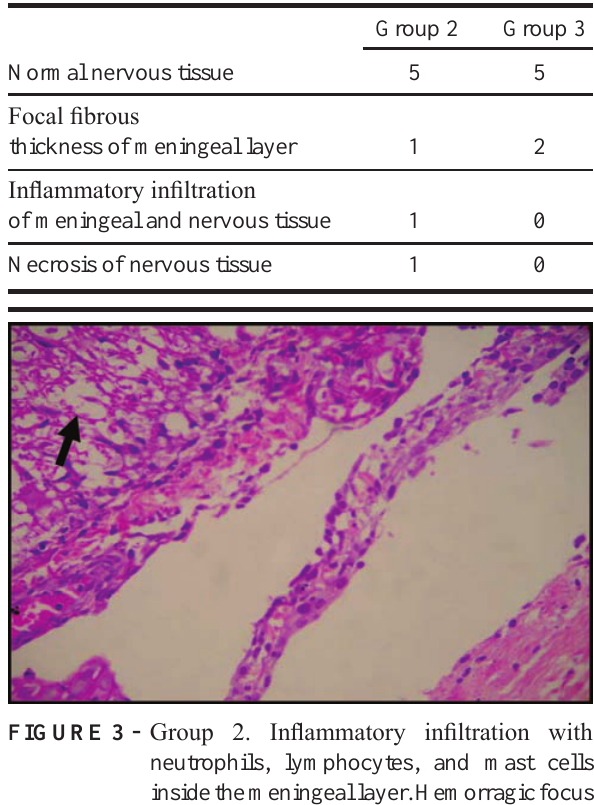
TABLE 3 - Histological findings in dogs from Groups 2 and